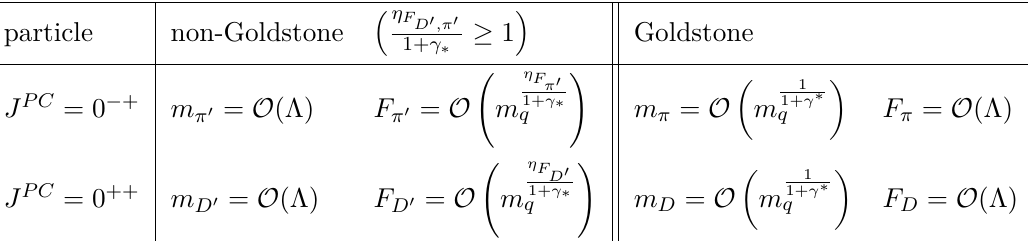
Table 1 . Overview of how the important parameters entering the explicitly and anomalously broken Ward identities behave in the conformal dilaton phase. The scale Λ stands for a generic hadronic scale which in QCD is usually referred to as Λ ( η (1 + γ ) ≥ 1 ) under mass-deformation will be discussed in section 3.1. The quantity γ F D 0 ,π 0 / ∗ the mass anomalous dimension at the IR fixed